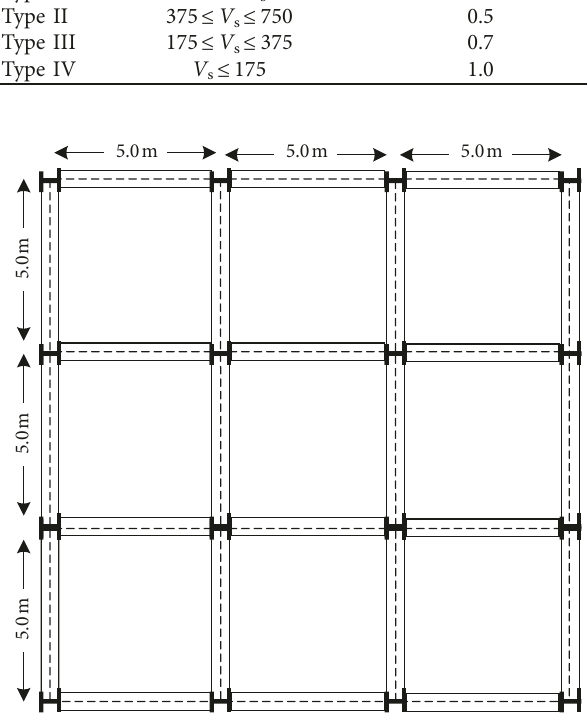
Figure 1: The plan view of the 5- and 8-story